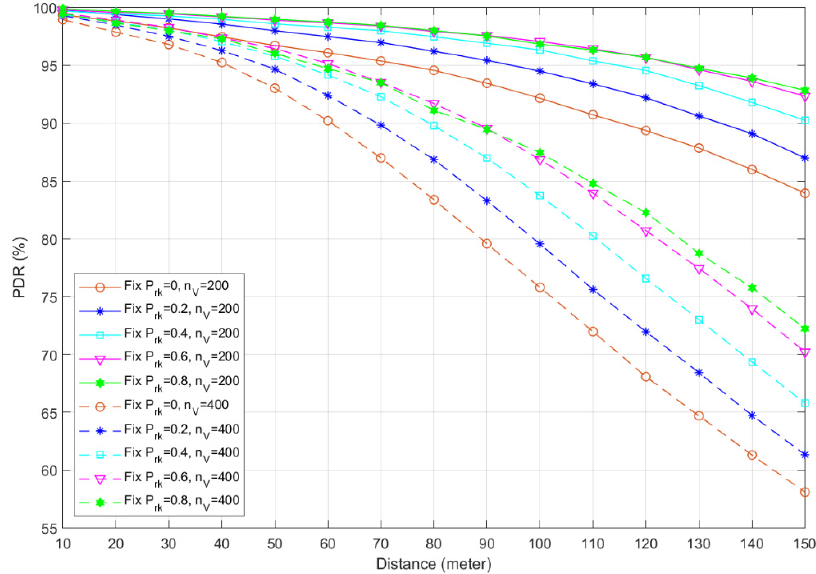
Figure 8. PDR performance of fixed P rk values for total vehicle numbers of n V = 200 and 400.